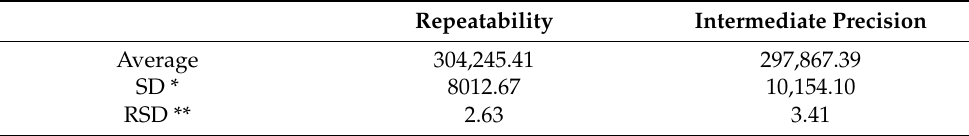
Table 3. Repeatability and intermediate precision results of the developed